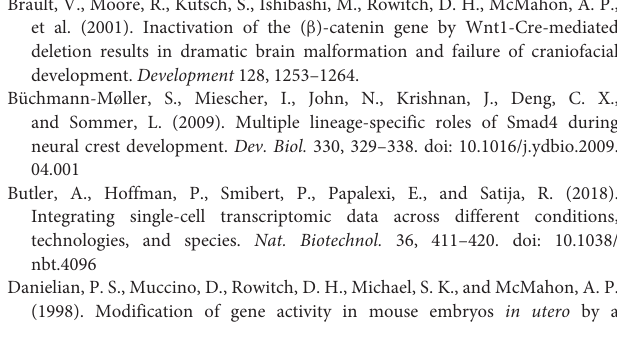
SUPPLEMENTARY FIGURE 1 | Wnt1-Cre2 and Sox10-Cre label the neural crest and the neural tube. Whole-mount images of Wnt1-Cre2 and Sox10-Cre were used to lineage trace neural crest. SUPPLEMENTARY FIGURE 2 | Cells harvested using Wnt1-Cre2 have a neuroepithelial gene signature compared to cells harvested using Sox10-Cre. (A) Violin and (B) density plot showing that the expression values for all samples used in the analysis are comparable. SUPPLEMENTARY FIGURE 3 | Single-cell sequencing reveals little co-expression of Wnt1 and Sox10 in E9.5 neural crest cells. (A) Violin plot and (B) scatter plot showing the count of RNA transcripts and mapped features for each cell. (C) Jackstraw plot showing the significance of 20 principal components. (D) Elbow plot showing the standard deviation of 20 principal components. (E) RNAScope for Wnt1 and Sox10 in transverse cranial cross-sections at 63 × and corresponding co-localization scatter plot showing the minimal overlap of Wnt1 and Sox10 . SUPPLEMENTARY FIGURE 4 | Single-cell ATAC sequencing reveals accessible motifs near Wnt1 in the neuroepithelium and Sox10 in neural crest. (A) Bar plot showing the significance of predicted motifs present in the accessible regions of chromatin at the Wnt1 and (B) Sox10 loci. SUPPLEMENTARY FIGURE 5 | Single-cell sequencing reveals little co-expression of Sox9 and Pax3 in E9.5 neural crest cells. (A) Bar plot quantifying the co-expression of PAX3 and SOX9. (B) Immunofluorescence of transverse mouse embryo cross-sections for PAX3 and SOX9 from E8.0 to